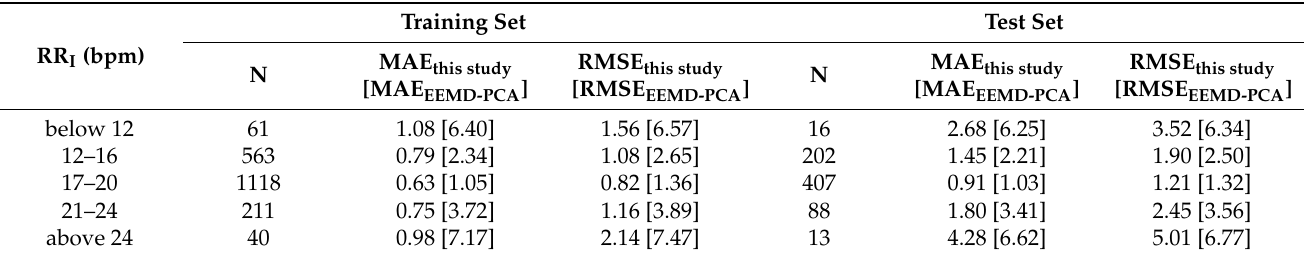
Table 4. Prediction performance in different ranges of respiratory